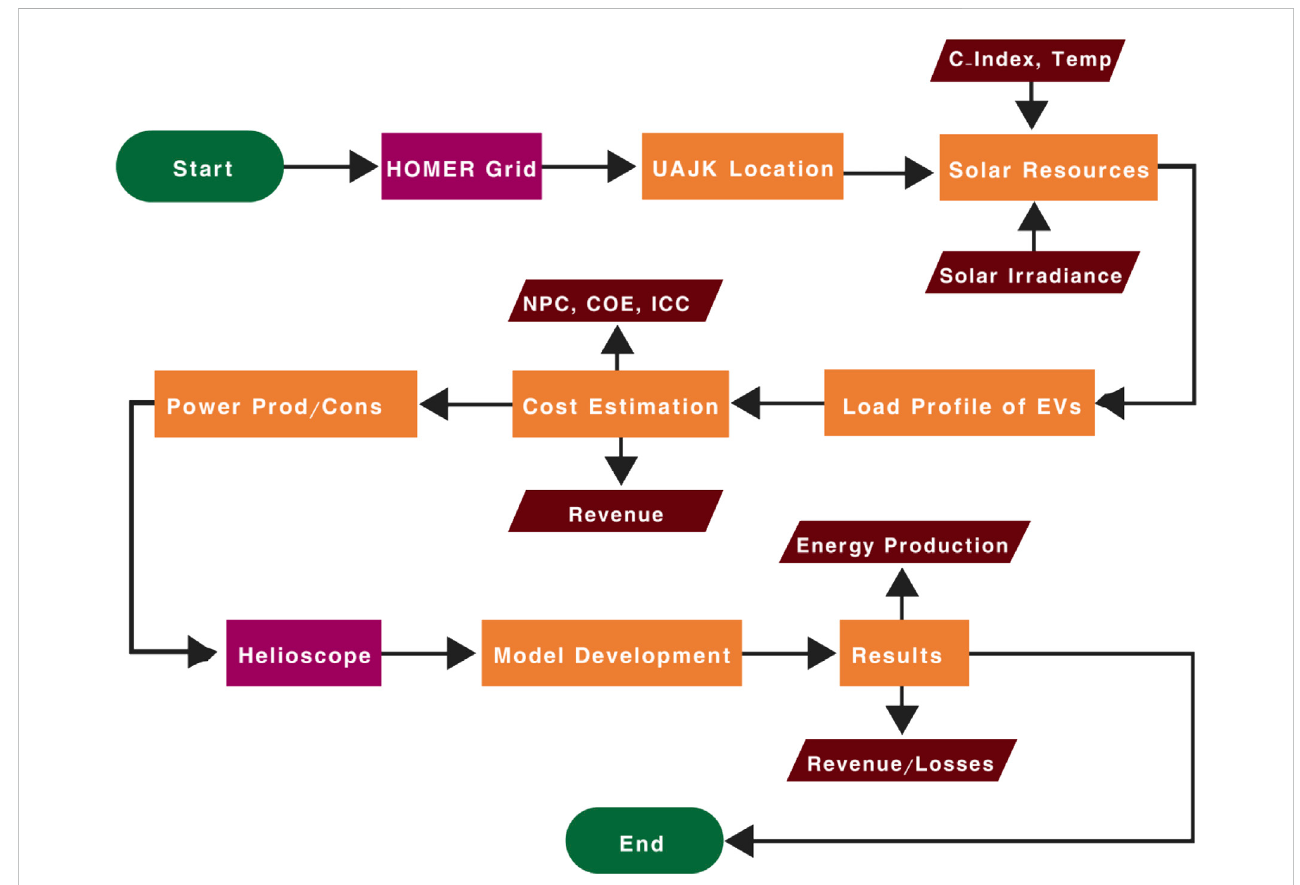
FIGURE 1 Flowchart for the proposed